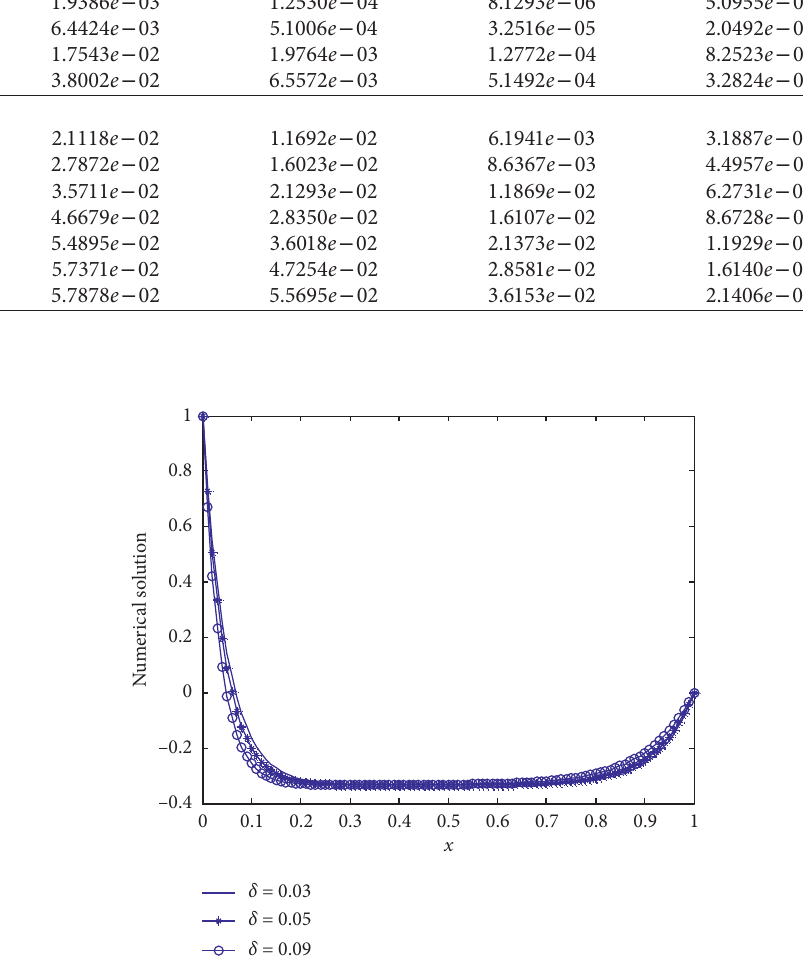
Figure 2: The numerical solution of Example 2 with ε � 0 . 01 and N �